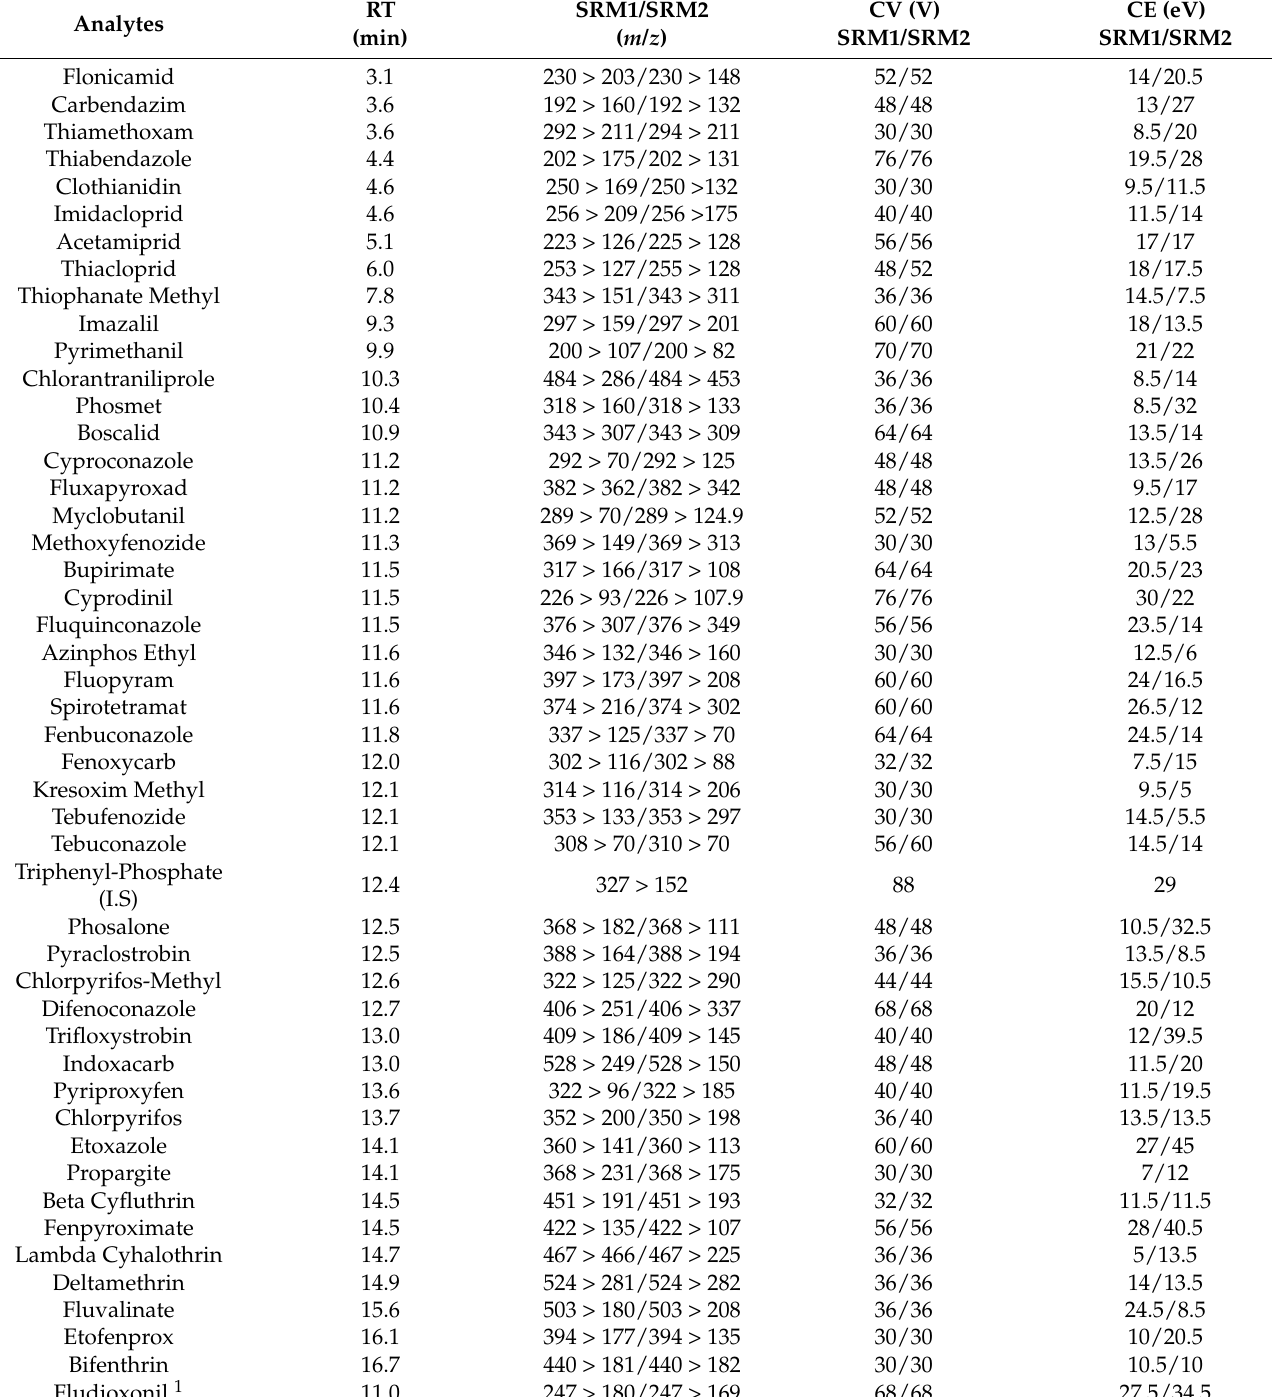
Table 1. Selected reaction monitoring (SRM) transitions of the target compounds ordered by retention time (RT). Capillary voltage (CV) and collision energy (CE) for the SRM1 and